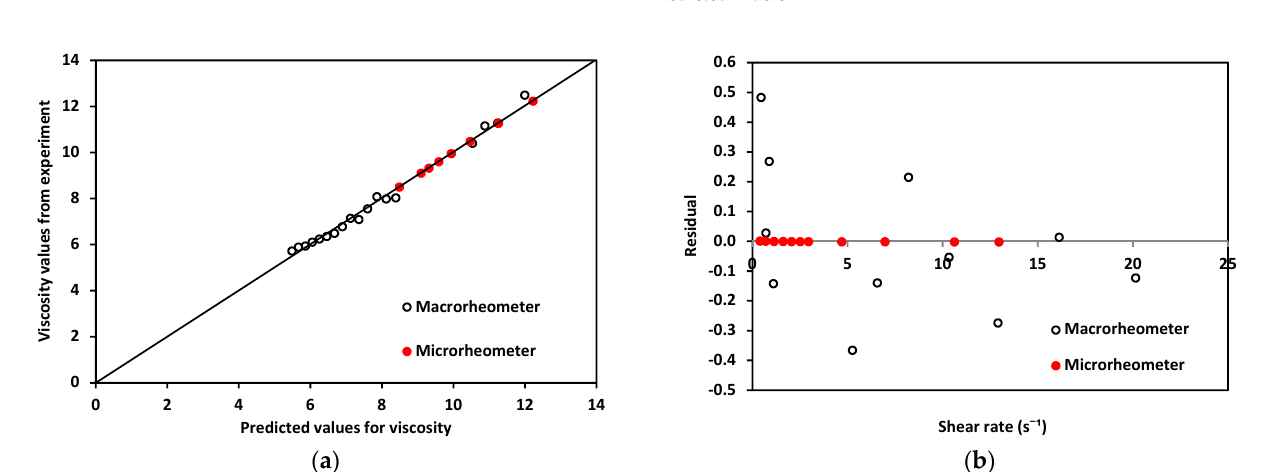
Figure 10. ( a ). Experimentally obtained viscosity values vs. predicted values for both devices using blood. ( b ) Residuals for macro and microrheometers.